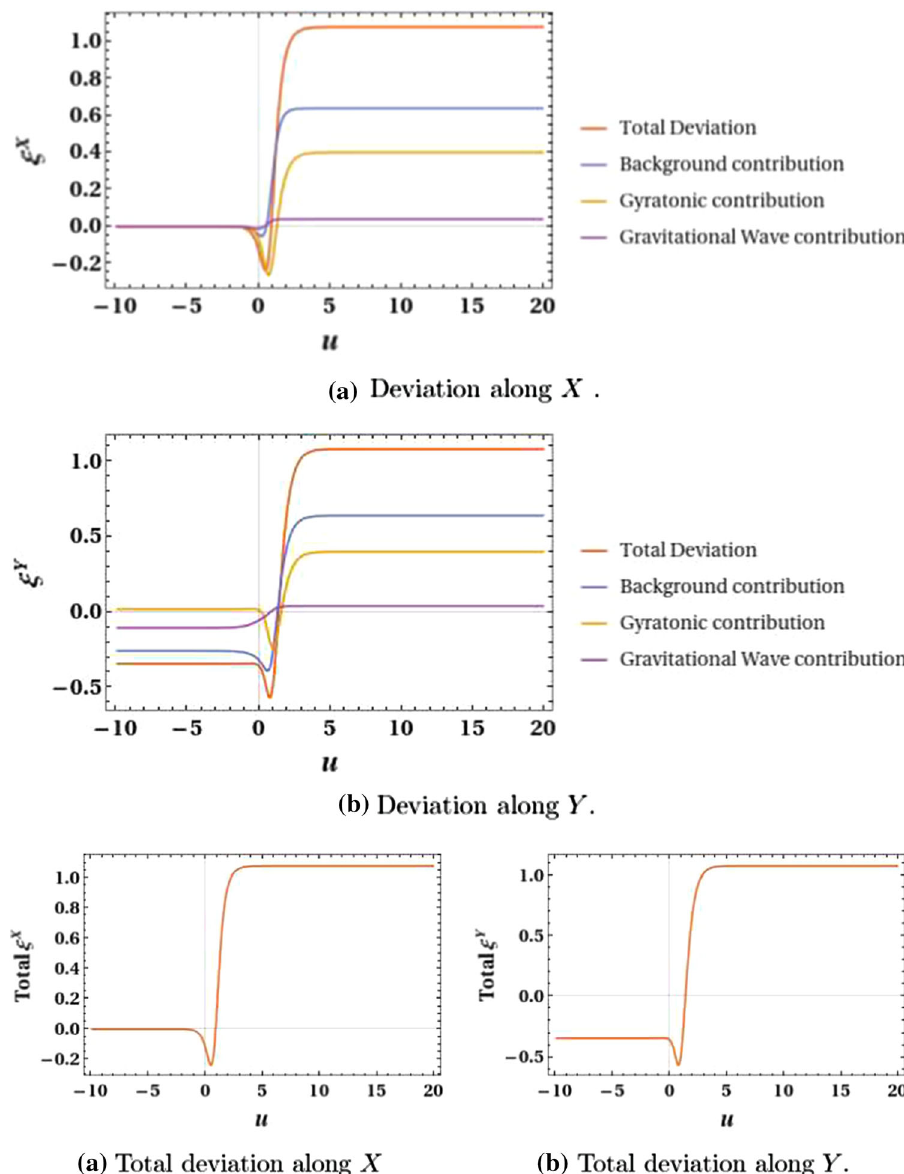
localised fucntions (eg. proportional to sech 2 u ) with the aim of studying memory